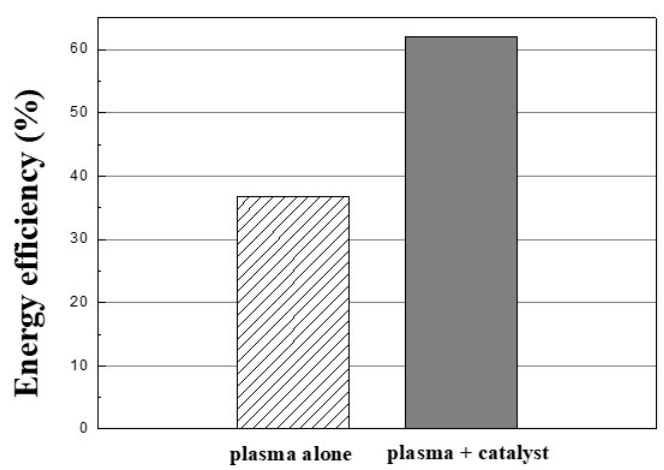
Figure 8. Energy efficiency of dry reforming obtained using the hybrid system. 4